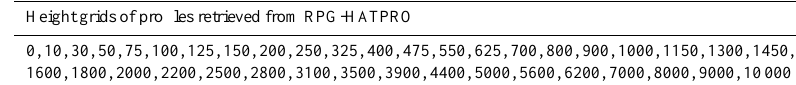
Figure 1. View from the west to the city of Innsbruck. In the foreground the airport is visible where the radio soundings are launched and the approximate position of the HATPRO on the roof of the university building with the scanning direction towards the east is indicated. The red triangle denotes the Patscherkofel mountaintop station. Table 1. Height grids of the temperature / humidity profile retrieval, expressed in meters over the instrument. Height grids of profiles retrieved from